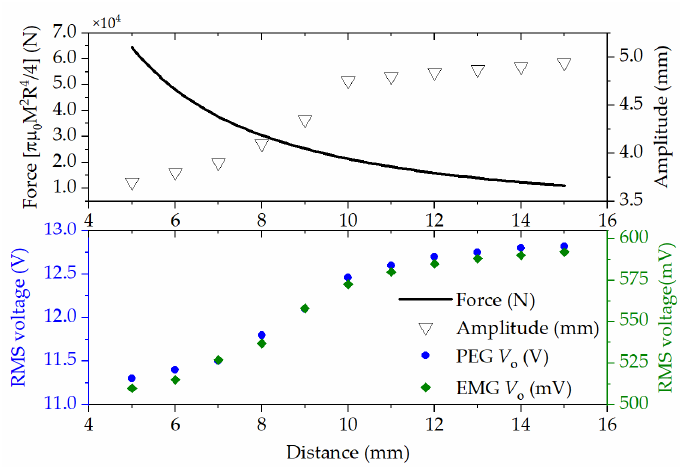
Figure 7. The effect of the vertical distance between magnets on the interaction, vibration amplitude and the PEG and EMG output voltages.